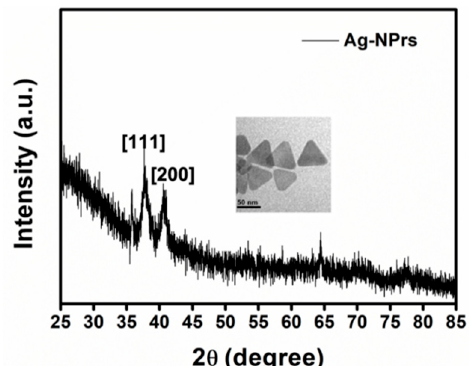
Figure 4. X-ray diffraction (XRD) pattern of triangular silver nanoprisms (Ag-NPrs); inset is the Ag-NPrs TEM image.